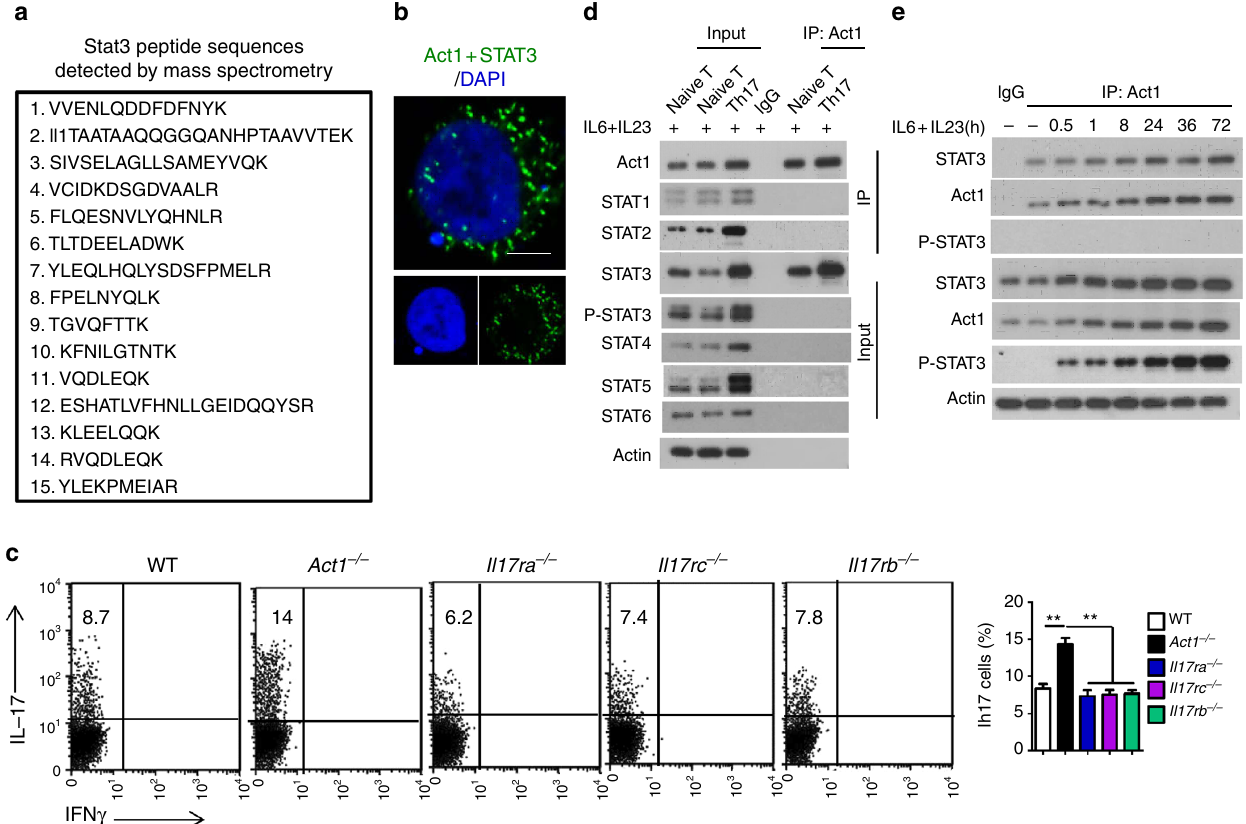
Fig. 1 Act1 physically interacts with STAT3. a Mass spectrometry analysis of Act1-associated proteins after immunoprecipitation via anti-Flag beads from lysates of HeLa cells transiently transfected to express Act1-Flag. Fifteen matched peptide sequences that correspond to STAT3 were identi fi ed. b HeLa cells were co-transfected with V5-Act1 and Flag-STAT3, followed by Duolink assay, in which mouse anti-V5 and rabbit anti-Flag antibody were used. Green dots present the interaction of STAT3 and Act1. Scale bars: 10 μ m. c Naive T cells isolated from spleens of indicated mice were polarized to Th17 with IL-23 + IL-6 for 3 days, followed by intracellular staining for IL-17A and IFN γ . d WT Naive T cells isolated from spleen were polarized into Th17 cells with IL-23 + IL-6. Lysates were then immunoprecipitated with anti-Act1 followed by western analysis of indicated proteins. e Naive CD4 + T cells were stimulated with IL-6 + 23 for the indicated time. Cells were then lysed and immunoprecipitated with anti-Act1 followed by western analysis with the indicated antibodies. Graphed as mean ± SEM. ** p < 0.01. N = 4 – 6/group. Two-tailed Student ’ s T test. All the data presented were from three independent